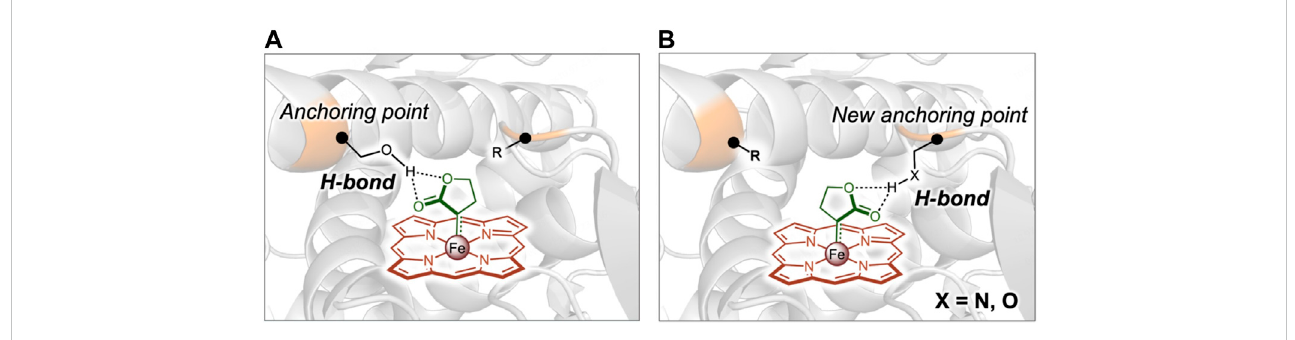
FIGURE 4 Reversing the enantioselectivity of enzymatic carbene N – H insertion by remodeling the interaction network. (A) , Hydrogen bond shown in enzyme variant with high enantioselectivity towards S -enantiomer. (B) , Newly constructed hydrogen bond to invert the enantioselectivity towards R -enantiomer. Reprinted with permission from (Calvó-Tusell et al.,